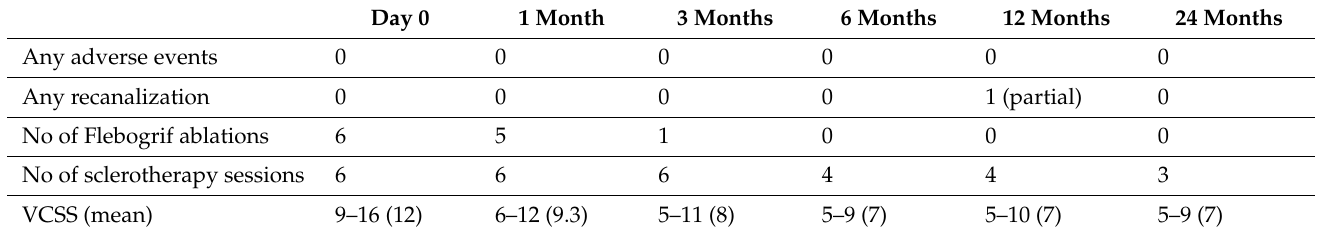
Table 2. Follow-up data of the study